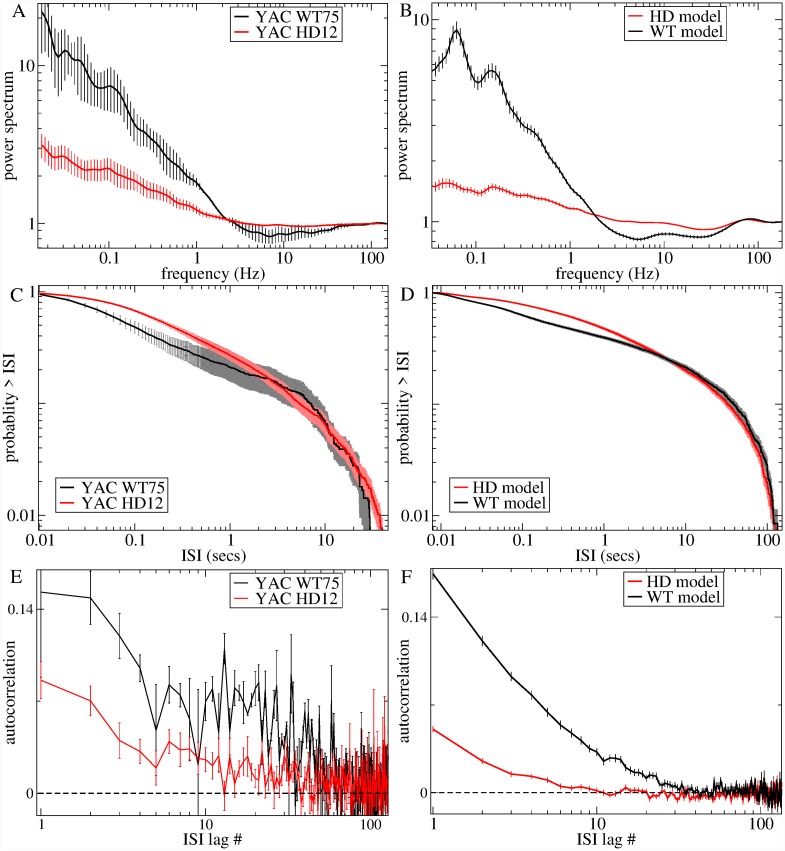
Comparison of experimental data and best fit model generated data.(a,b) Spike count power-spectra. (c,d) Cumulative ISI distribution. (e,f) Lagged ISI serial autocorrelation function (a,c,e) Experimental data for two age restricted datasets, the YACWT group, denoted ‘WT75’ (black) and the YACHD group, denoted ‘HD12’ (red). Results shown are averages across all the spike trains in each group and bars show SEM across these spike trains (see Methods). (b,d,f) Network simulation generated data with parameter settings WT: gE = 50, gI = 33 (black), HD: gE = 40, gI = 41 (red) which are best fit for the experimental group datasets, WT75, and HD12, shown in (a,c,e). Results are averages across all active cells in each network simulation and bars show the SEM (see Methods).